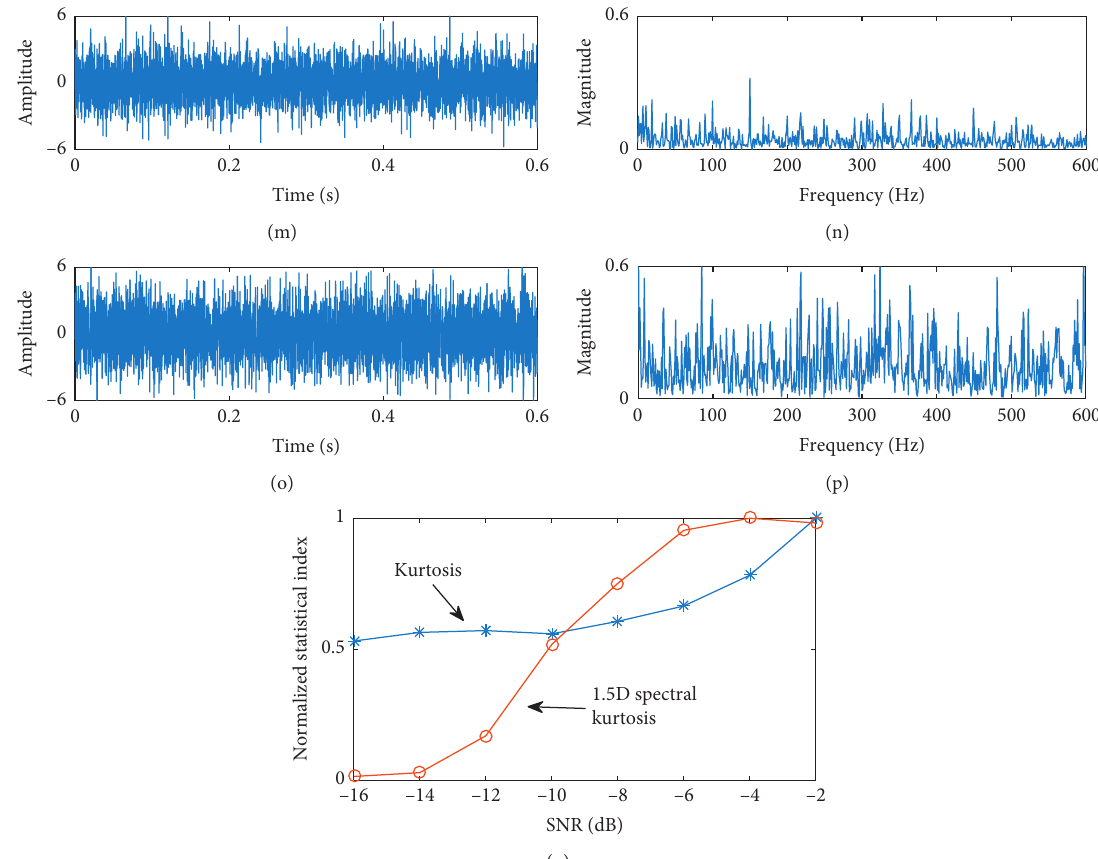
Figure 2: Curve of the kurtosis and 1.5D spectral kurtosis with different SNR. (a) SNR � − 2 dB . (b) SNR � − 2 dB . (c) SNR � − 4 dB . (d) SNR � − 4 dB . (e) SNR � − 6 dB . (f) SNR � − 6 dB . (g) SNR � − 8 dB . (h) SNR � − 8 dB . (i) SNR � − 10 dB . (g) SNR � − 10 dB . (k)